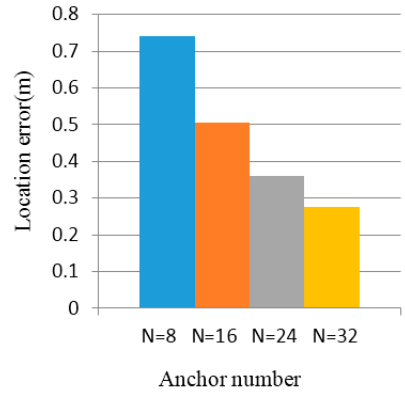
Figure 16. Location error when intensity value is fluctuation 5%.